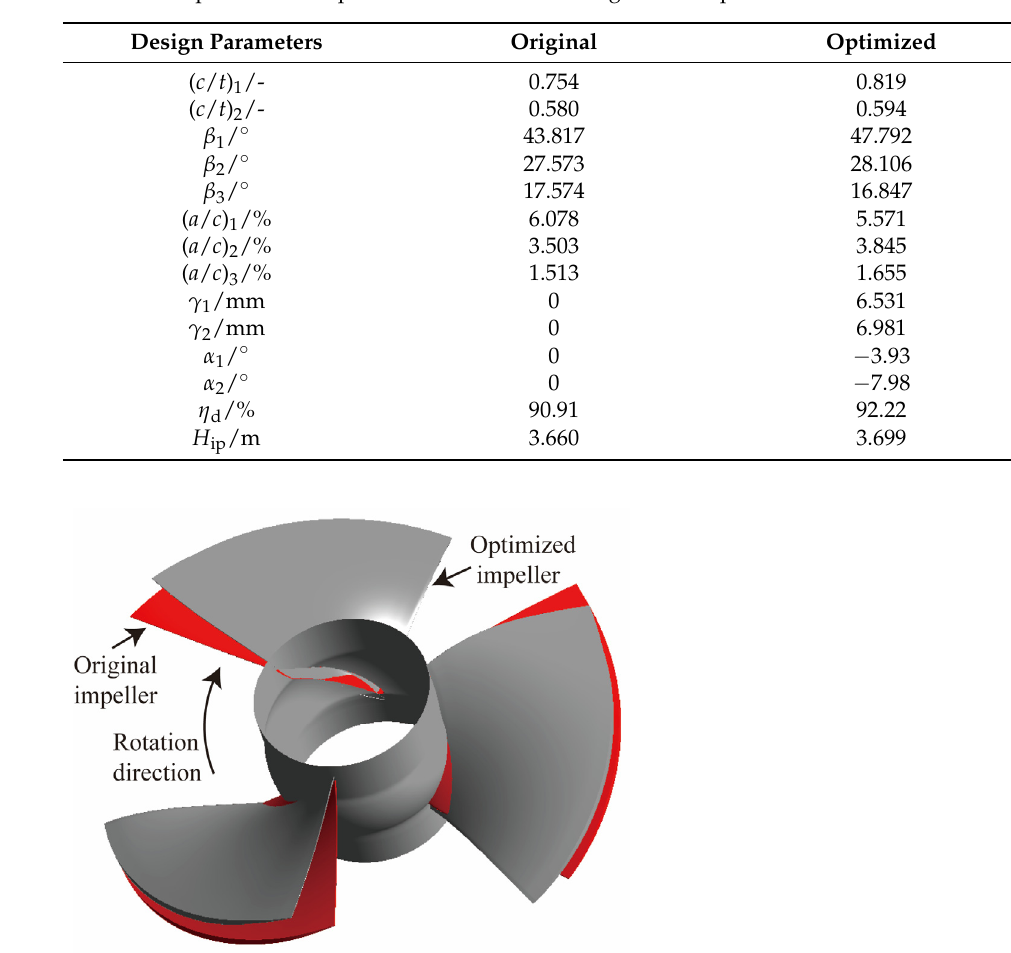
Figure 12. Comparison of the impeller shapes before and after optimization.